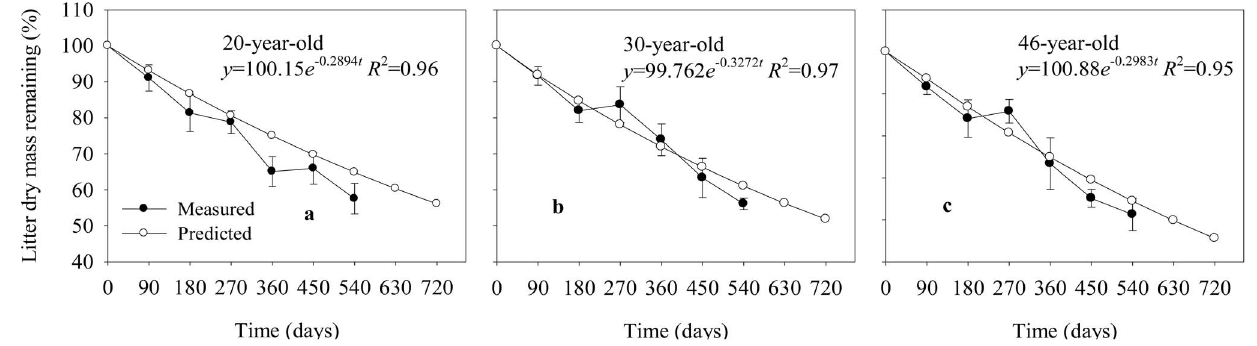
Figure 2. Observed ( N ) and predicted ( # ) values of litter dry mass remaining across the experimental period in different-aged Pinus massoniana forests (mean ± 1SD, n =9).